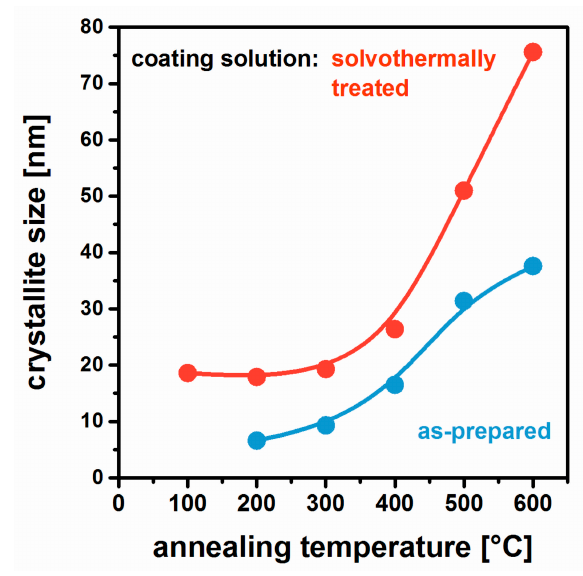
Figure 17. MgF 2 crystallite size as determined by XRD of films using as-prepared and solvothermally treated coating solutions as a function of annealing temperature. Based on [53].